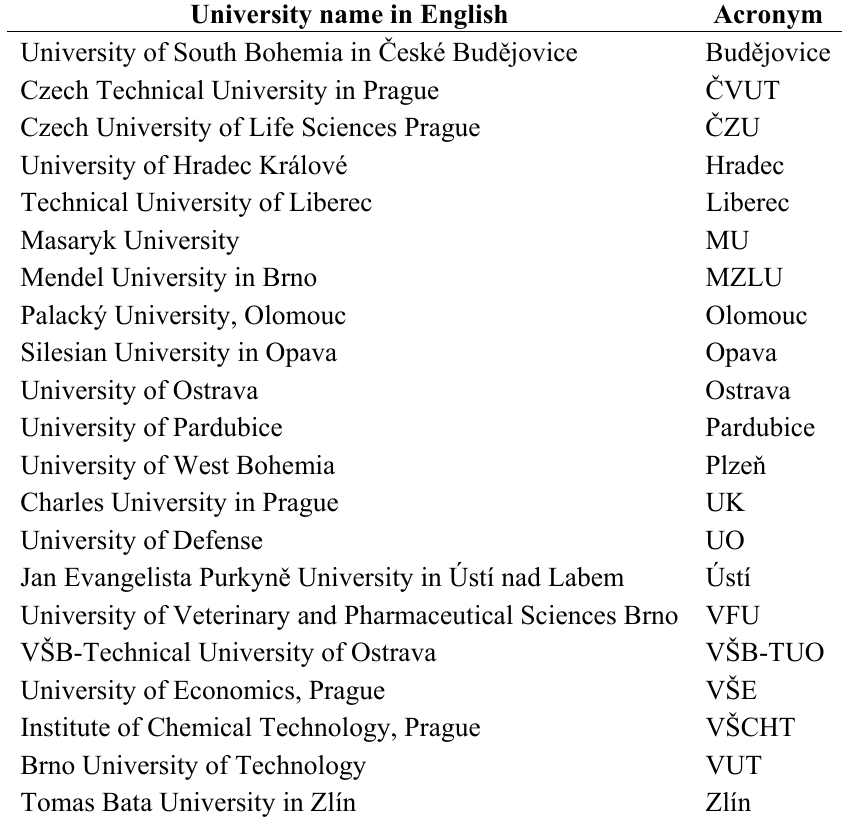
Table 1. List of universities and their